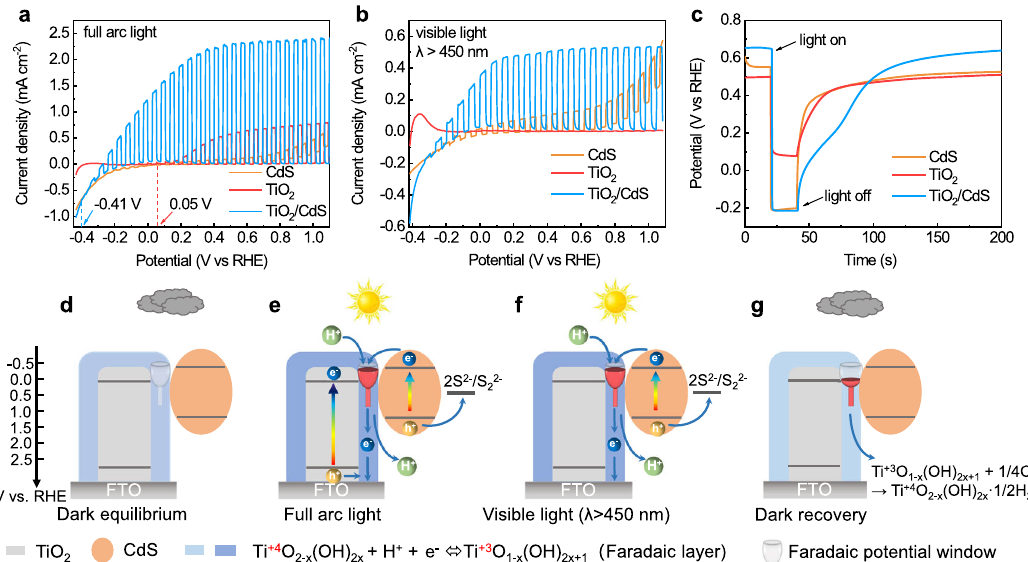
Fig. 4 Characteristic and mechanism of isoenergetic charge transfer in a Faradaic junction. Linear-sweep voltammetry curves of TiO 2 , CdS and TiO 2 / CdS in 1 M Na 2 S aqueous solution under chopped full-arc Xe lamp illumination without ( a ) and with ( b ) a fi lter (wavelength >450 nm); ( c ) open-circuit potential of TiO 2 , CdS, and TiO 2 /CdS in 1 M Na 2 S aqueous solution with air in the dark and under illumination; ( d – g ) interface charge-transfer mechanisms in a TiO 2 /CdS heterojunction in the dark and under